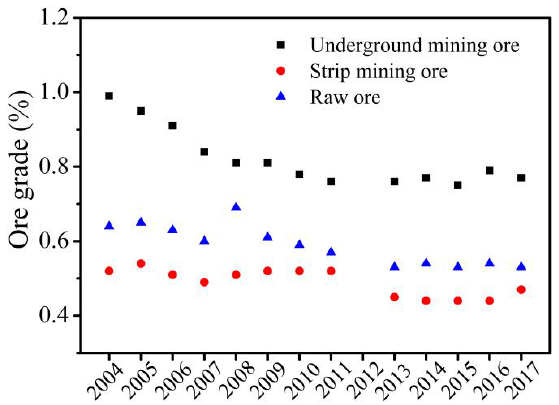
Figure 8. Copper ore grade varying from 2004 to 2017.